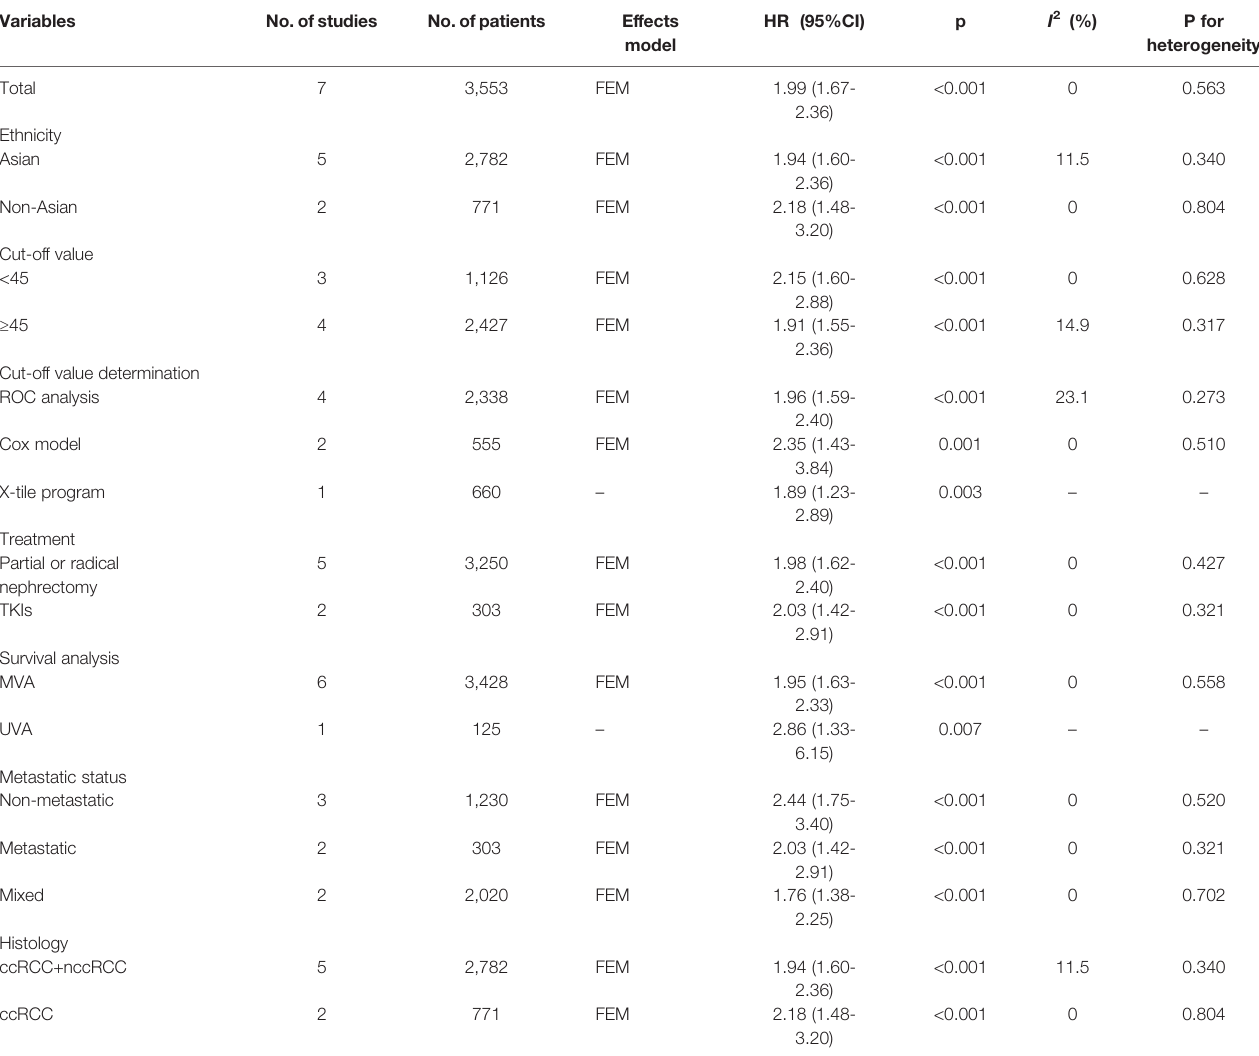
TABLE 4 | Results of subgroup meta-analysis for progression-free survival/disease-free survival/recurrence-free survival.